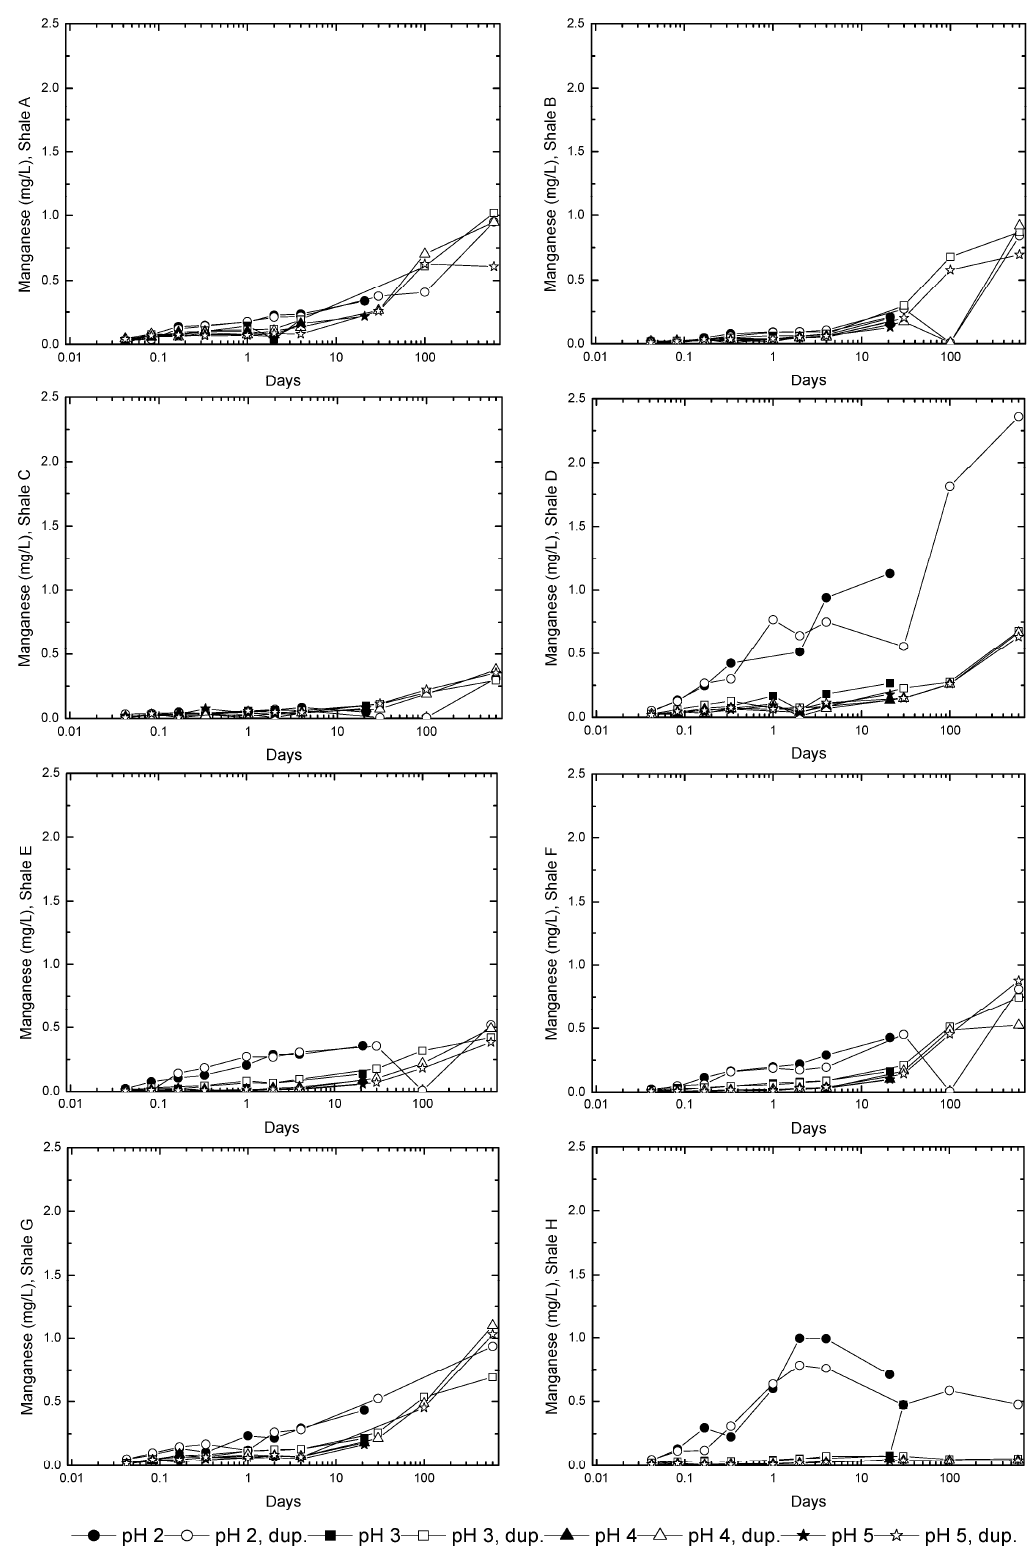
Figure 8. Solution Manganese concentration recorded over time for all reaction vessels for all samples. Points on lines mark sample intervals from experiment commencement and 1, 2, 3 and 8 h, and 1, 2, 4, 21, 30, 100 and 600 days (logarithmic scale). The legend indicates initial sample